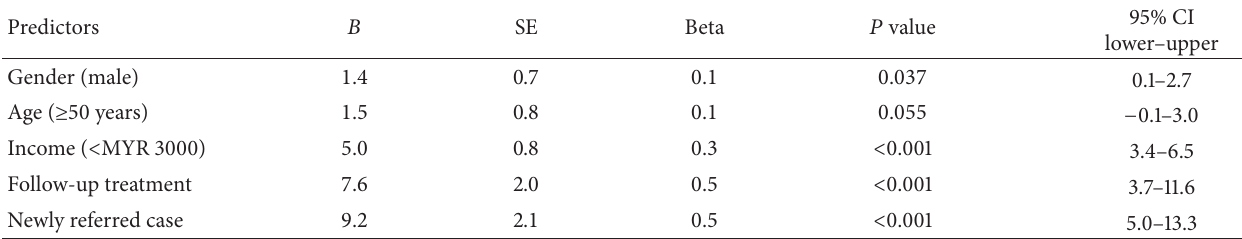
Table 4: Factors associated with health service satisfaction among patients by multiple linear regression ( 𝑛 =